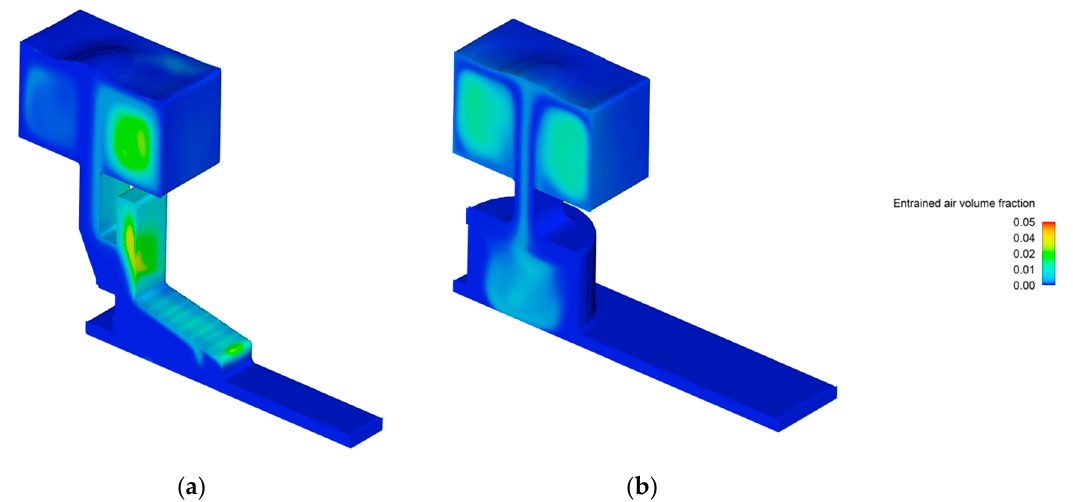
Figure 9. Entrained air volume fraction profiles the ( a ) trident gate (TG) and ( b ) vortex gate (VG) designs.